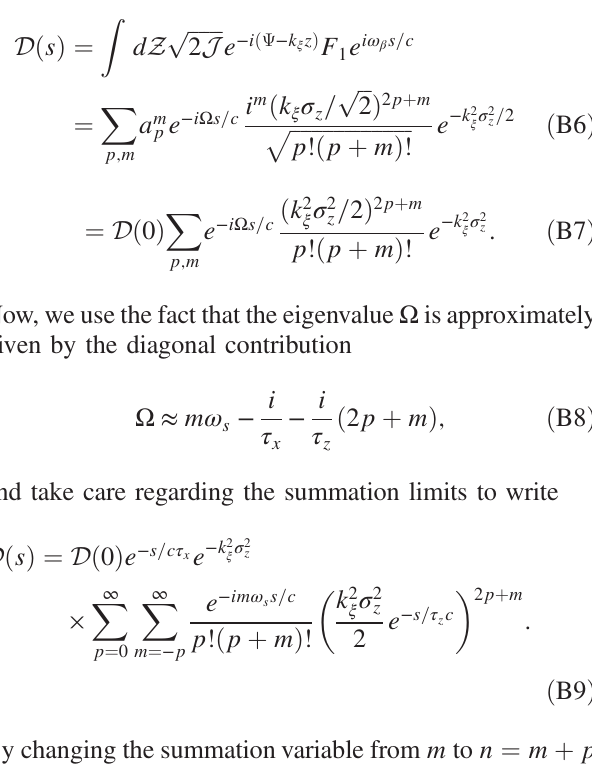
τ ≈ 53 . 1 , ω τ ≈ 61 . 9 , and s x s z